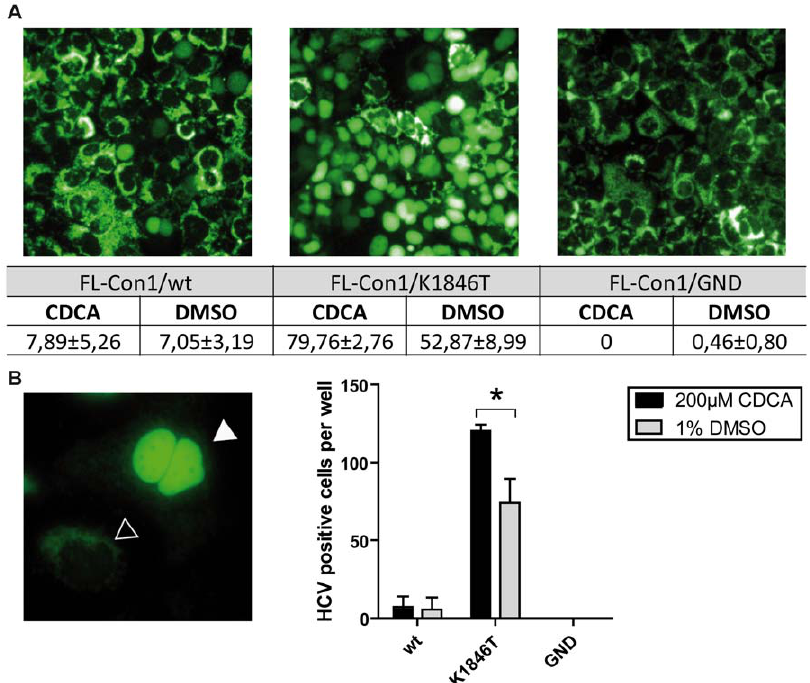
Figure 7. Detection of HCV replication and virus infectivity in the presence of CDCA using Lunet GFP-NLS-MAVS- reporter cells. A: Lunet MAVS-GFP reporter cells were transfected with given HCV Con1 full length genomes. Ten days after transfection relocalization of GFP to the nucleus was assessed by fluorescence microscopy. Numbers below the panels depict the percentage of cells displaying GFP in the nucleus + / 2 standard deviation. B: Lunet cells were transfected with given genomes, co-seeded with naı¨ve Lunet GFP-NLS-MAVS (1:1) and cocultured in the presence or absence of CDCA cells for four days. Subsequently the number of cells showing a nuclear localized GFP was determined by counting of 50 randomly chosen microscopic fields. The left panel shows an example of two infected cells (white arrow) displaying nuclear localized GFP and a non-infected cell (black arrow) after co-culturing with Lunet cells transfected with Con1/K1846T. The right panel depicts mean values and standard deviations from 2 independent experiments. A significant difference in infection efficiency by addition of 200 m M CDCA is indicated by an asterisk (p=0.0486).